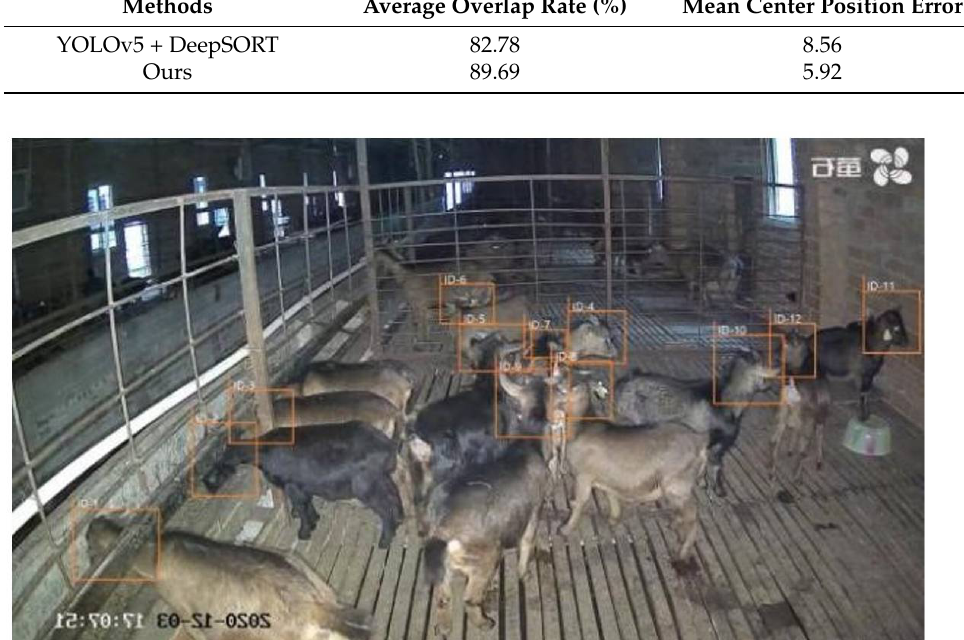
Figure 13. The combination of object detection network and object tracking network. Table 3. Comparison of object tracking algorithms.